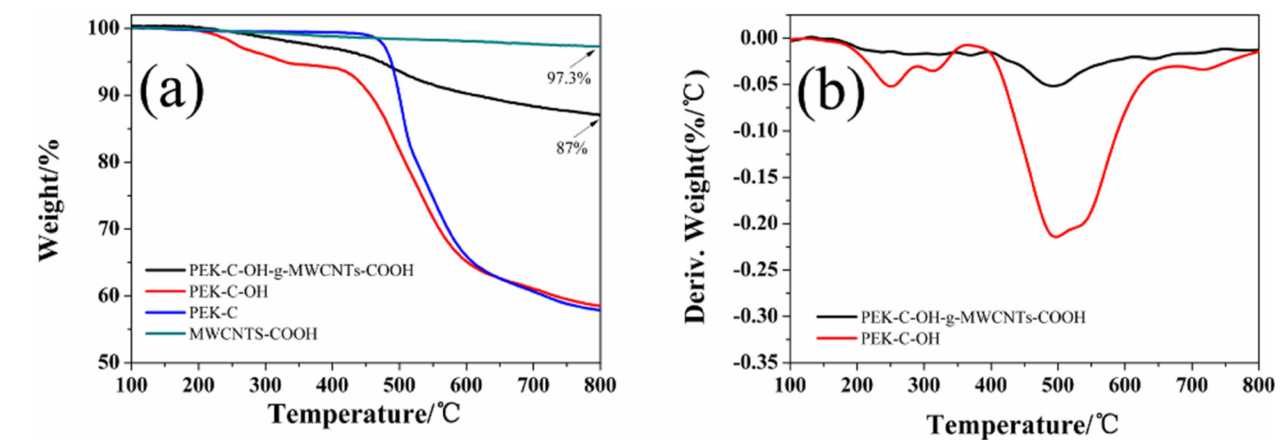
Figure 4. ( a ) TGA of PEK-C, PEK-C-OH, MWCNTs-COOH and PEK-C-OH-g-MWCNTs-COOH; ( b ) DTG of PEK-C-OH and PEK-C-OH-g-MWCNTs-COOH.